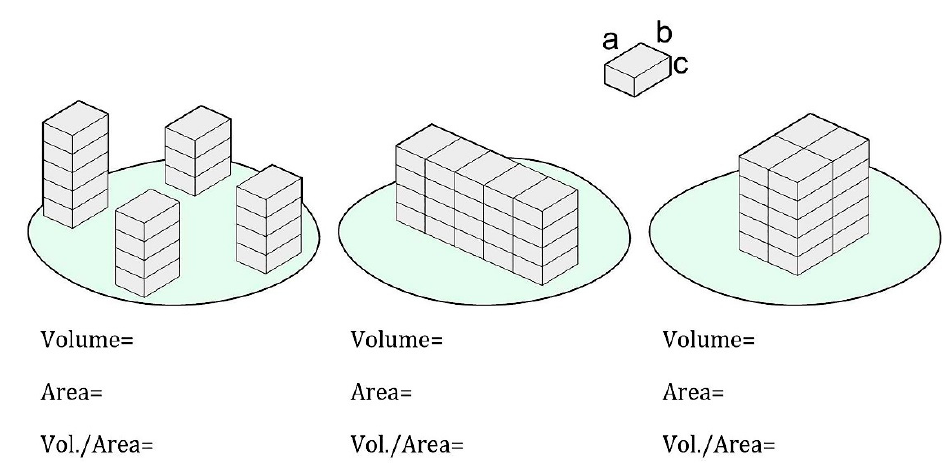
Figure 6. Volumetric arrangements formed by the same block unit axbxc. Own source.